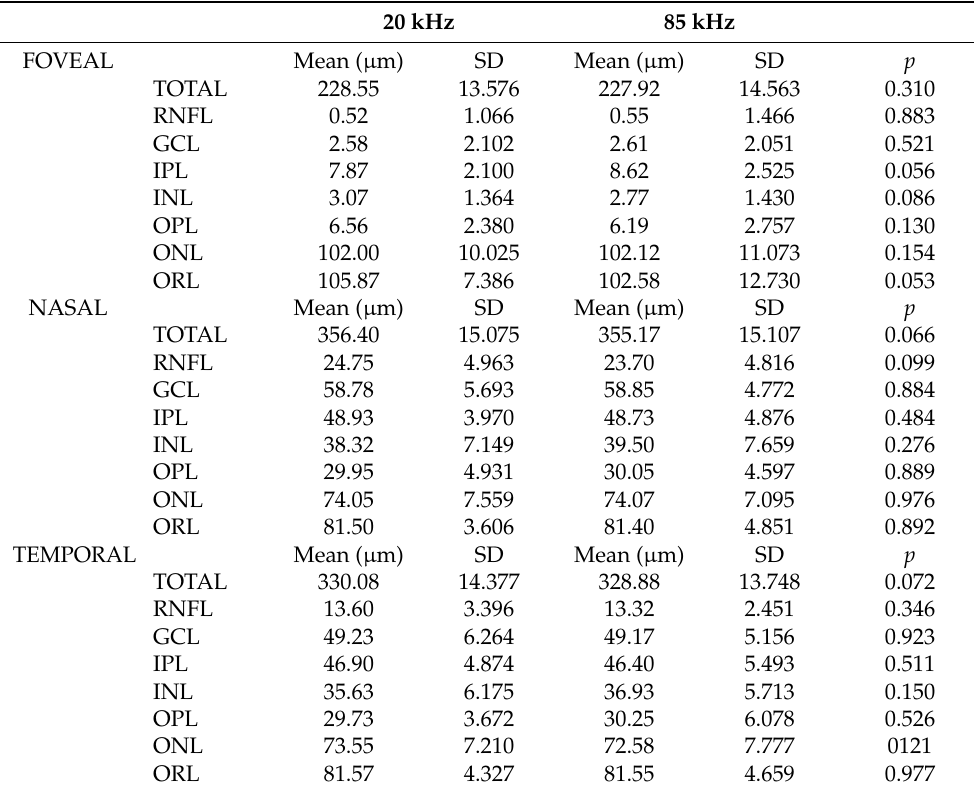
Table 1. Thickness measurements ( µ m) of the retinal layers assessed in the subfoveal, nasal, and temporal retina. Mean value and standard deviation were recorded. The p values are reported, and p < 0.05 were assumed as statistically significant (RNFL: retinal nerve fiber layer; GCL: ganglion cell layer; IPL: inner plexiform layer; INL: inner nuclear layer; OPL: outer plexiform layer; ONL: outer nuclear layer; ORL: outer retinal